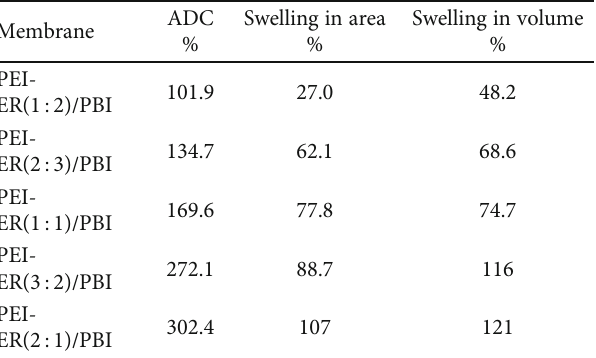
Figure 4: TGA curves of di ff erent PEI-ER/PBI semi-IPN membranes. Table 1: Acid doping content (ADC) and swelling rate of di ff erent semi-IPN